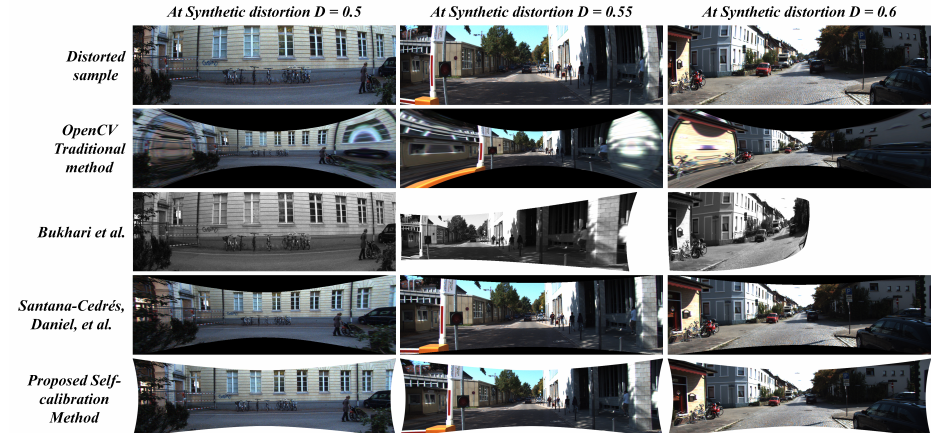
Figure 15. Comparison between proposed method against contemporary self-calibration and OpenCV traditional algorithms on Synthetically distorted KITTI data (D = 0.5 ∼ 0.6).